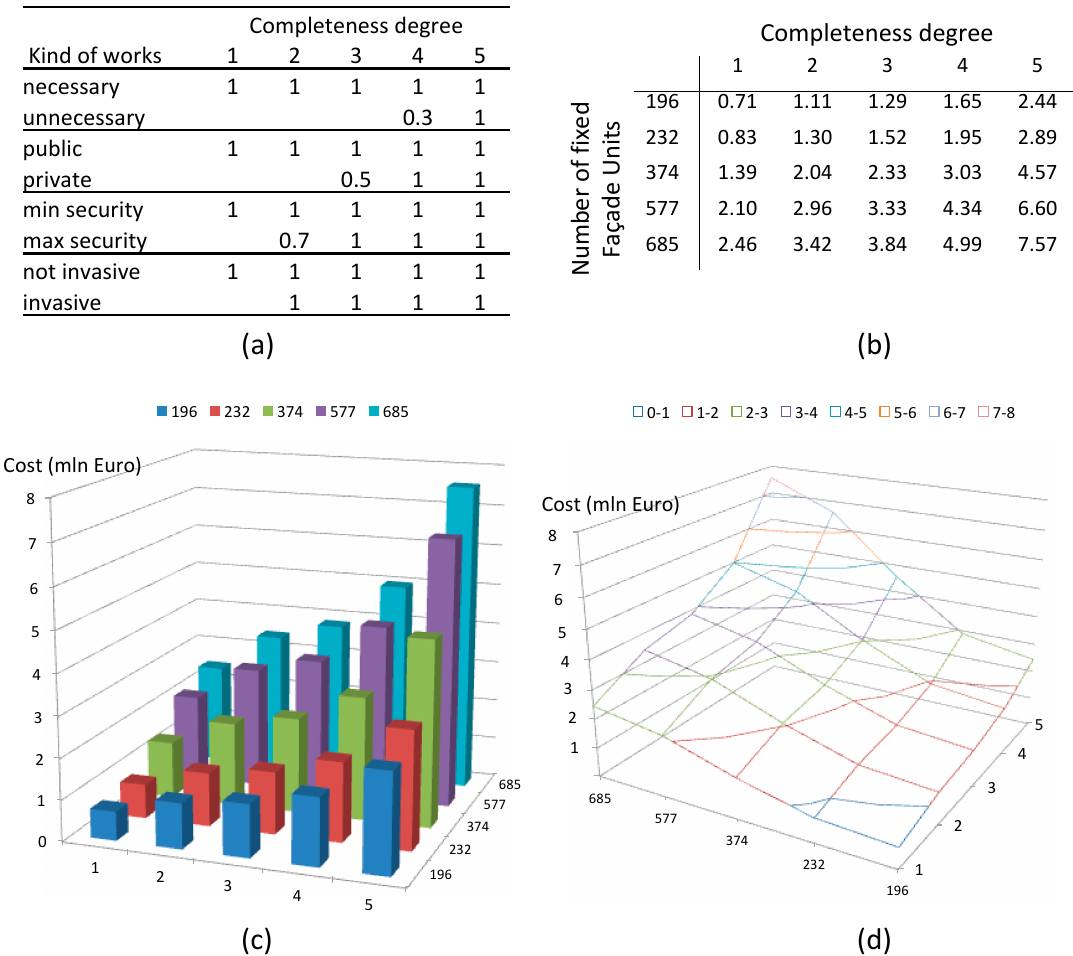
Figure 3. ( a ) Combination of security and completeness; ( b ) table of total cost for each strategy given by the combination of the two above mentioned performances; ( c ) graph of the total costs of each of the 25 strategies displayed in table ( b ); ( d ) 3D isocost functions displaying the trade-off between completeness and the number of façades involved for each level of cost.